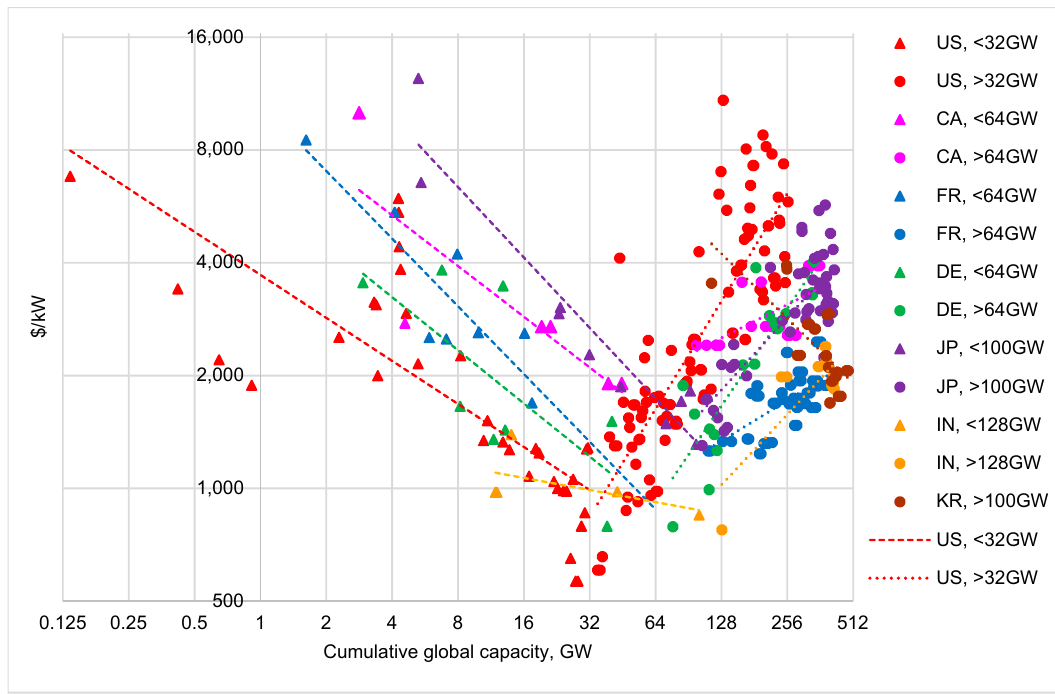
Figure 3. Regression lines for seven countries: OCC plotted against cumulative global capacity of construction starts.